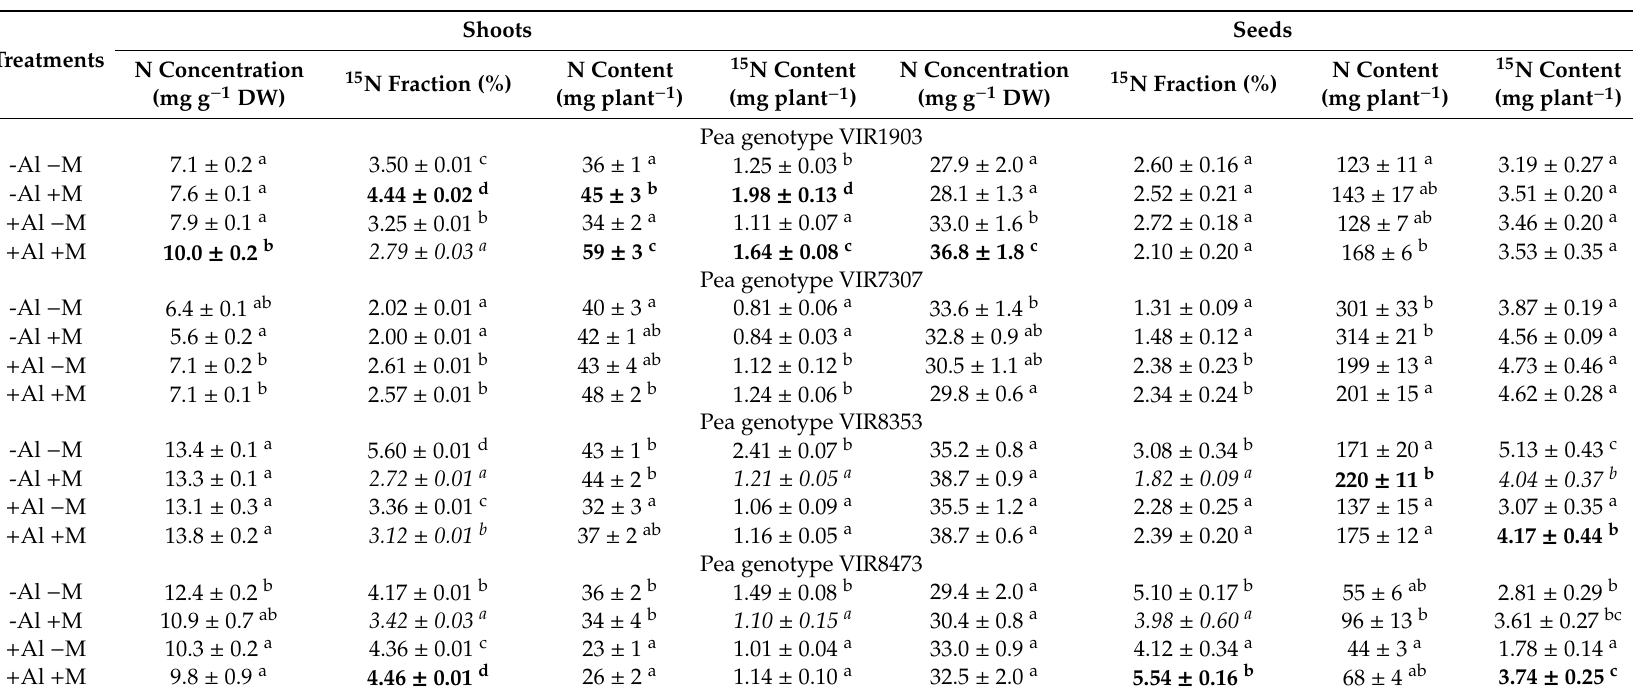
Table 1. Concentration and content of nitrogen in shoots and seeds of pea genotypes inoculated with microbial consortium and grown in neutralized or Al-supplemented